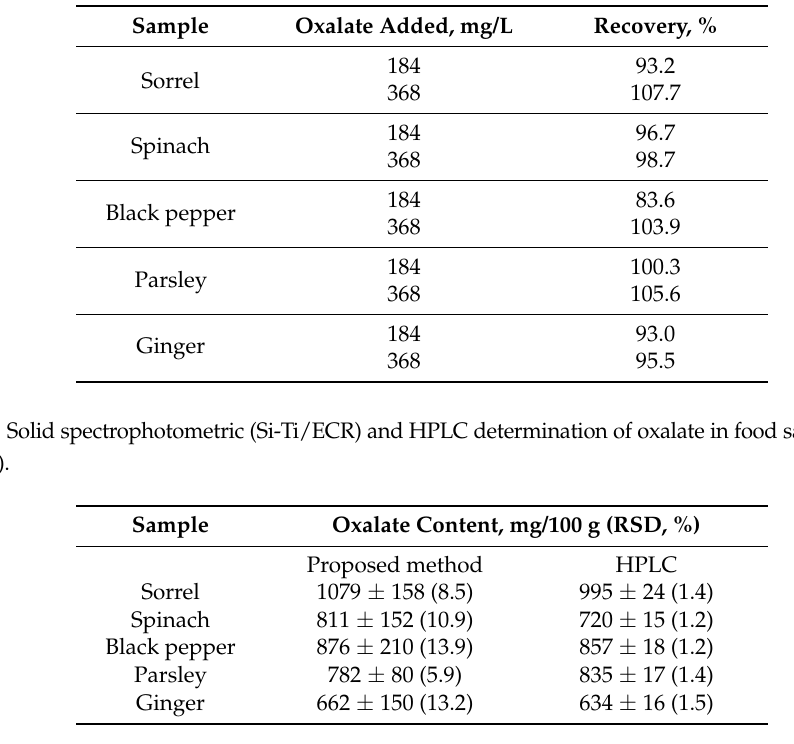
Table 4. Recovery test of solid phase spectrophotometric determination of oxalate in food samples ( n = 3).